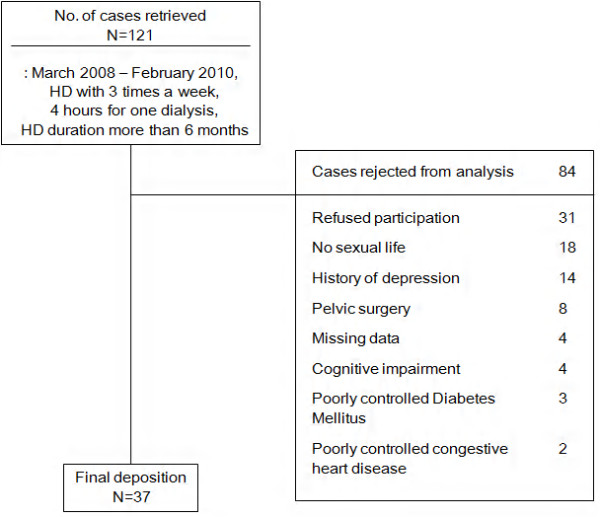
Patient deposition.